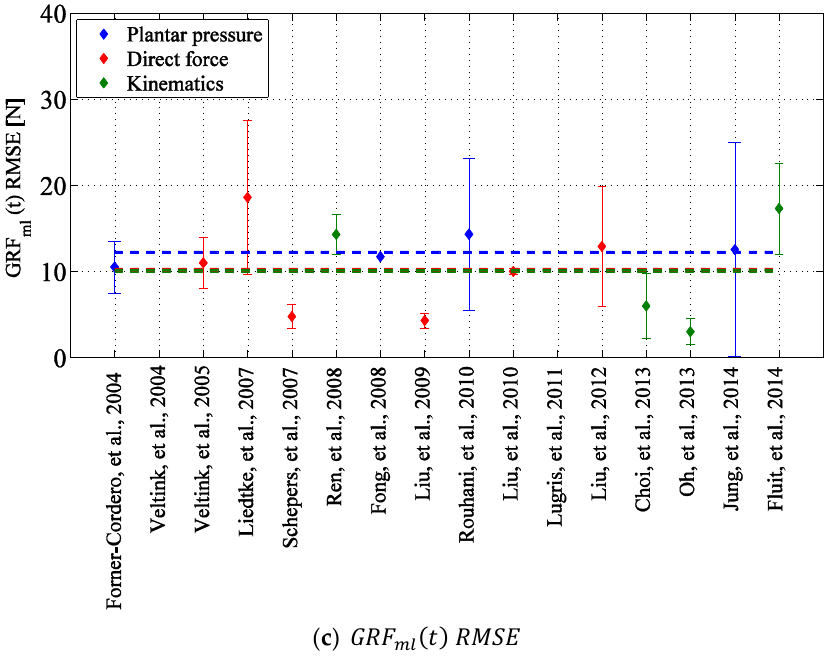
Figure 21. Comparison of the mean standard deviation of the 𝑅𝑀𝑆𝐸 of the estimated ( a ) 𝐺𝑅𝐹 𝑣 (𝑡) ; ( b ) 𝐺𝑅𝐹 𝑎𝑝 (𝑡) and ( c ) 𝐺𝑅𝐹 𝑚𝑙 (𝑡) signals for different methods. The average of mean values for each class of methods is shown with a dashed line with corresponding colour.